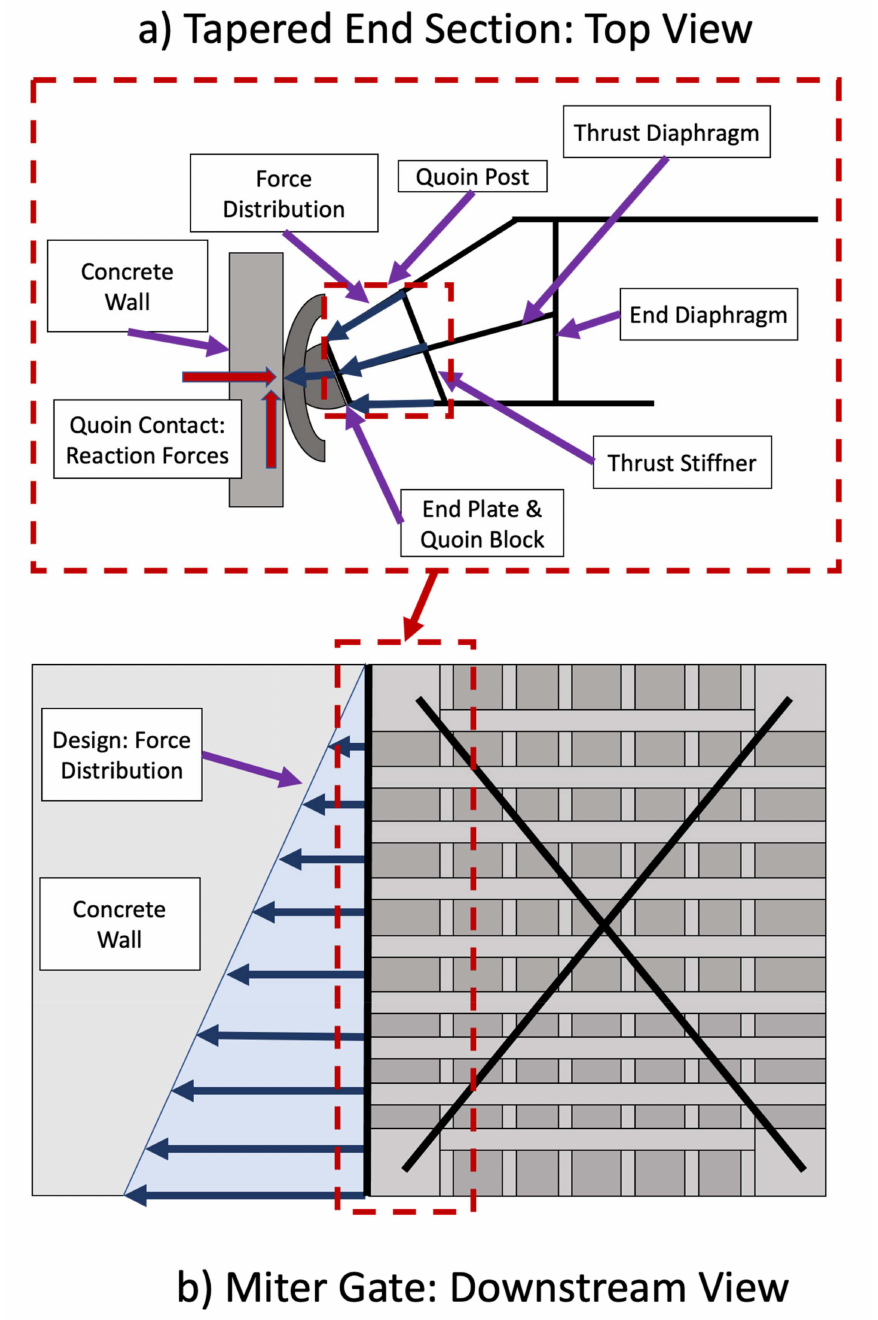
Figure 6. ( a ) Top view of the tapered end section and ( b ) front view of miter gate leaf with force